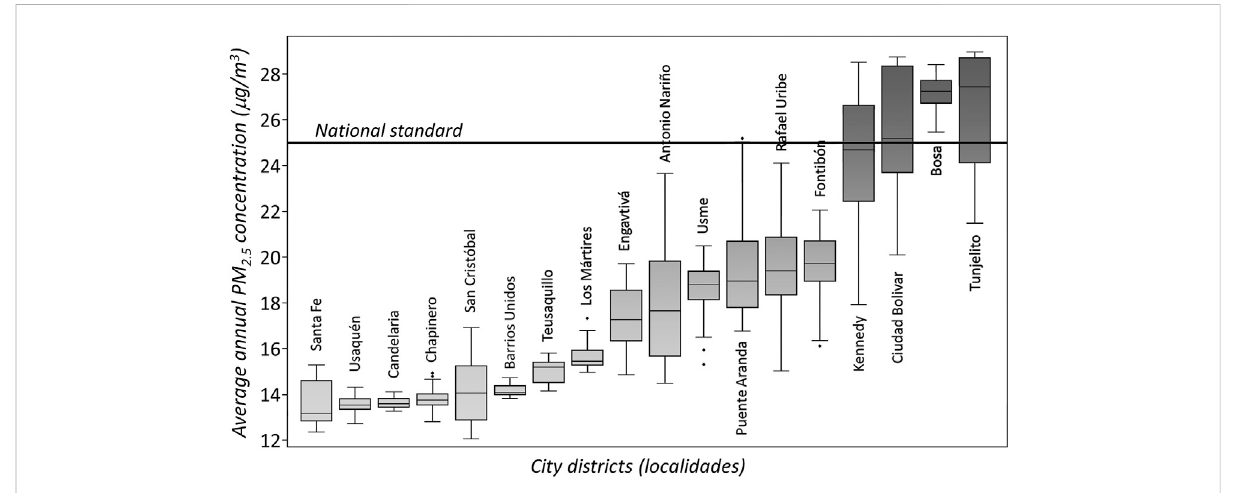
FIGURE 4 Boxplots of the 2018 yearly average PM 2.5 concentration level for the neighborhoods of each district of the